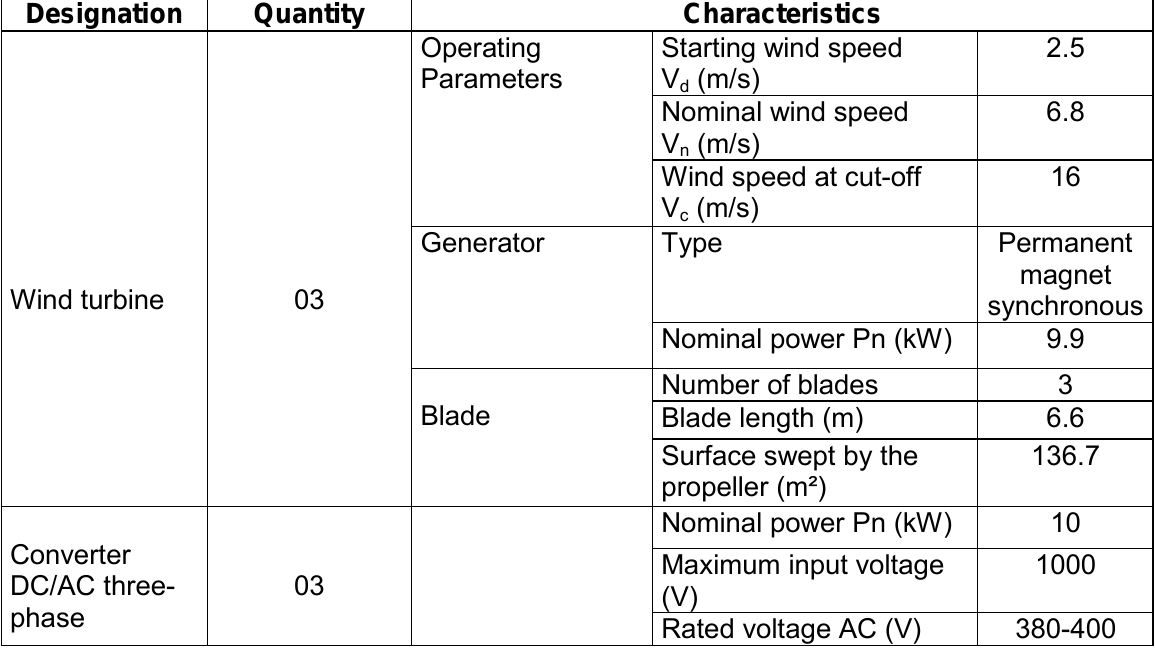
Table 2. Essential characteristics of the micro wind power plant